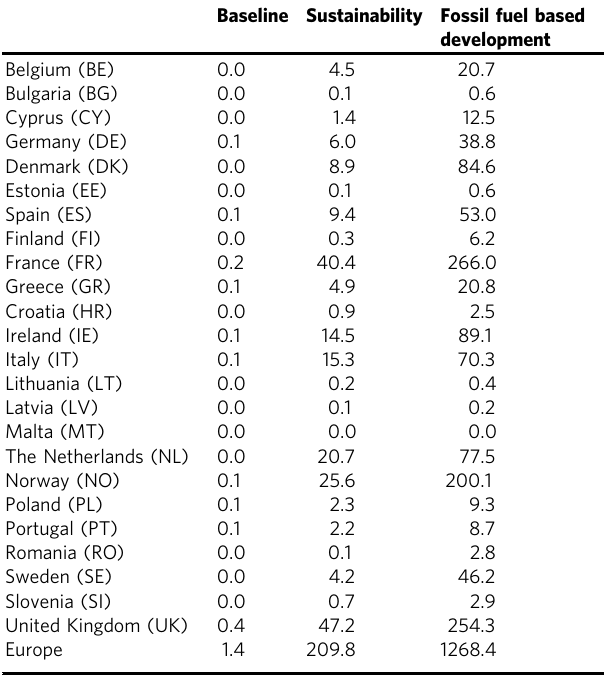
per country and for Europe. Baseline values are also shown in the fi rst